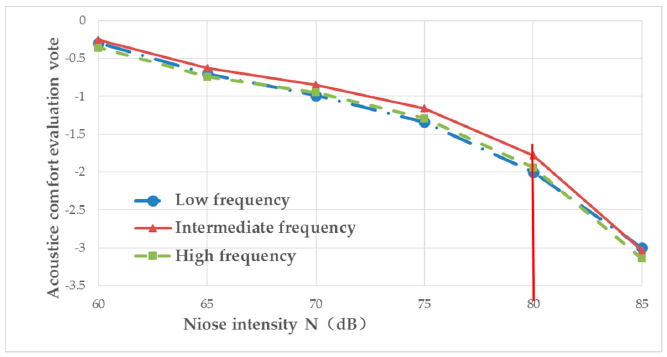
Figure 11. Non-dimensional function curve of acoustic comfort (low frequency/intermediate frequency/high frequency).